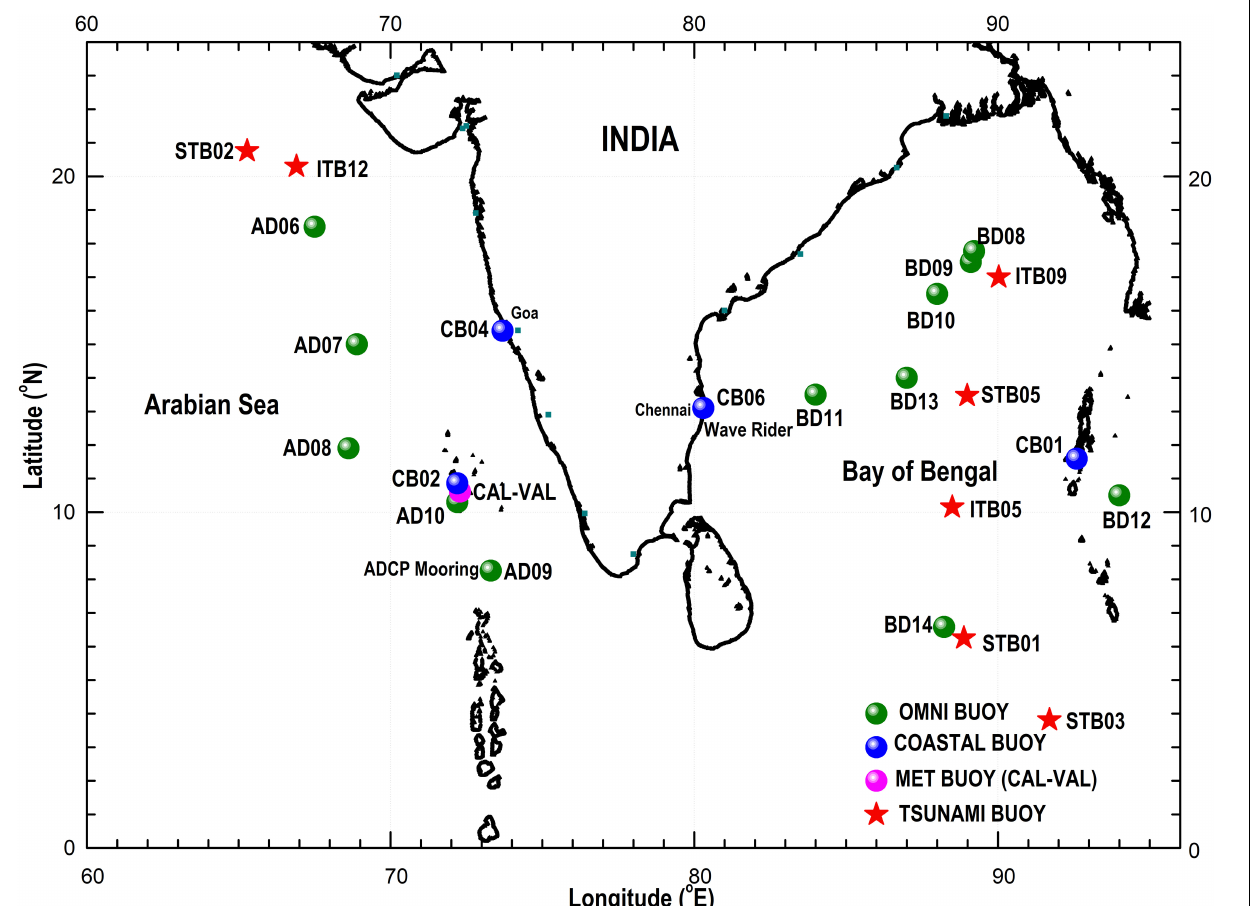
FIGURE 1 | Moored data buoy and the Indian moored buoy network in North Indian